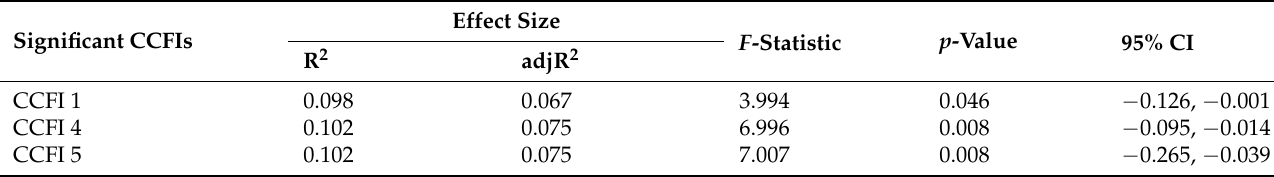
Table 7. Predictive model performance indices and